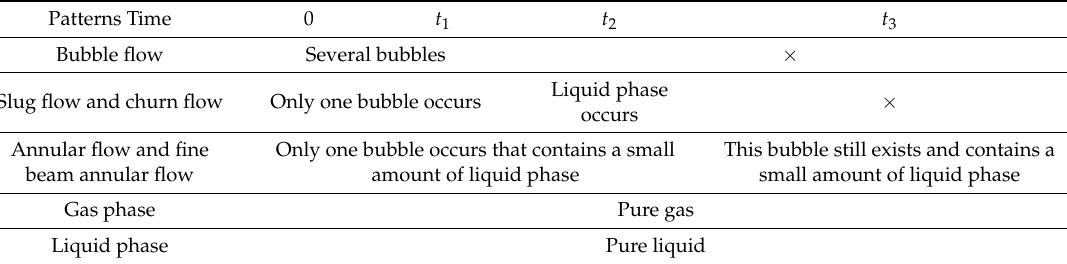
Table 2. Automatic identification principles of two-phase flow patterns.